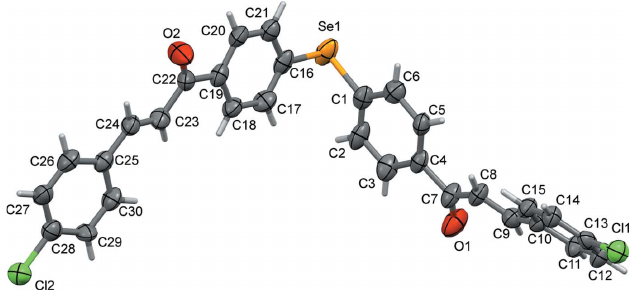
Figure 1 The molecular structure of the title compound, with the atom labelling and displacement ellipsoids drawn at the 50% probability Table 1 Short contacts (A˚ ) in the crystal of the title compound. Atom 1